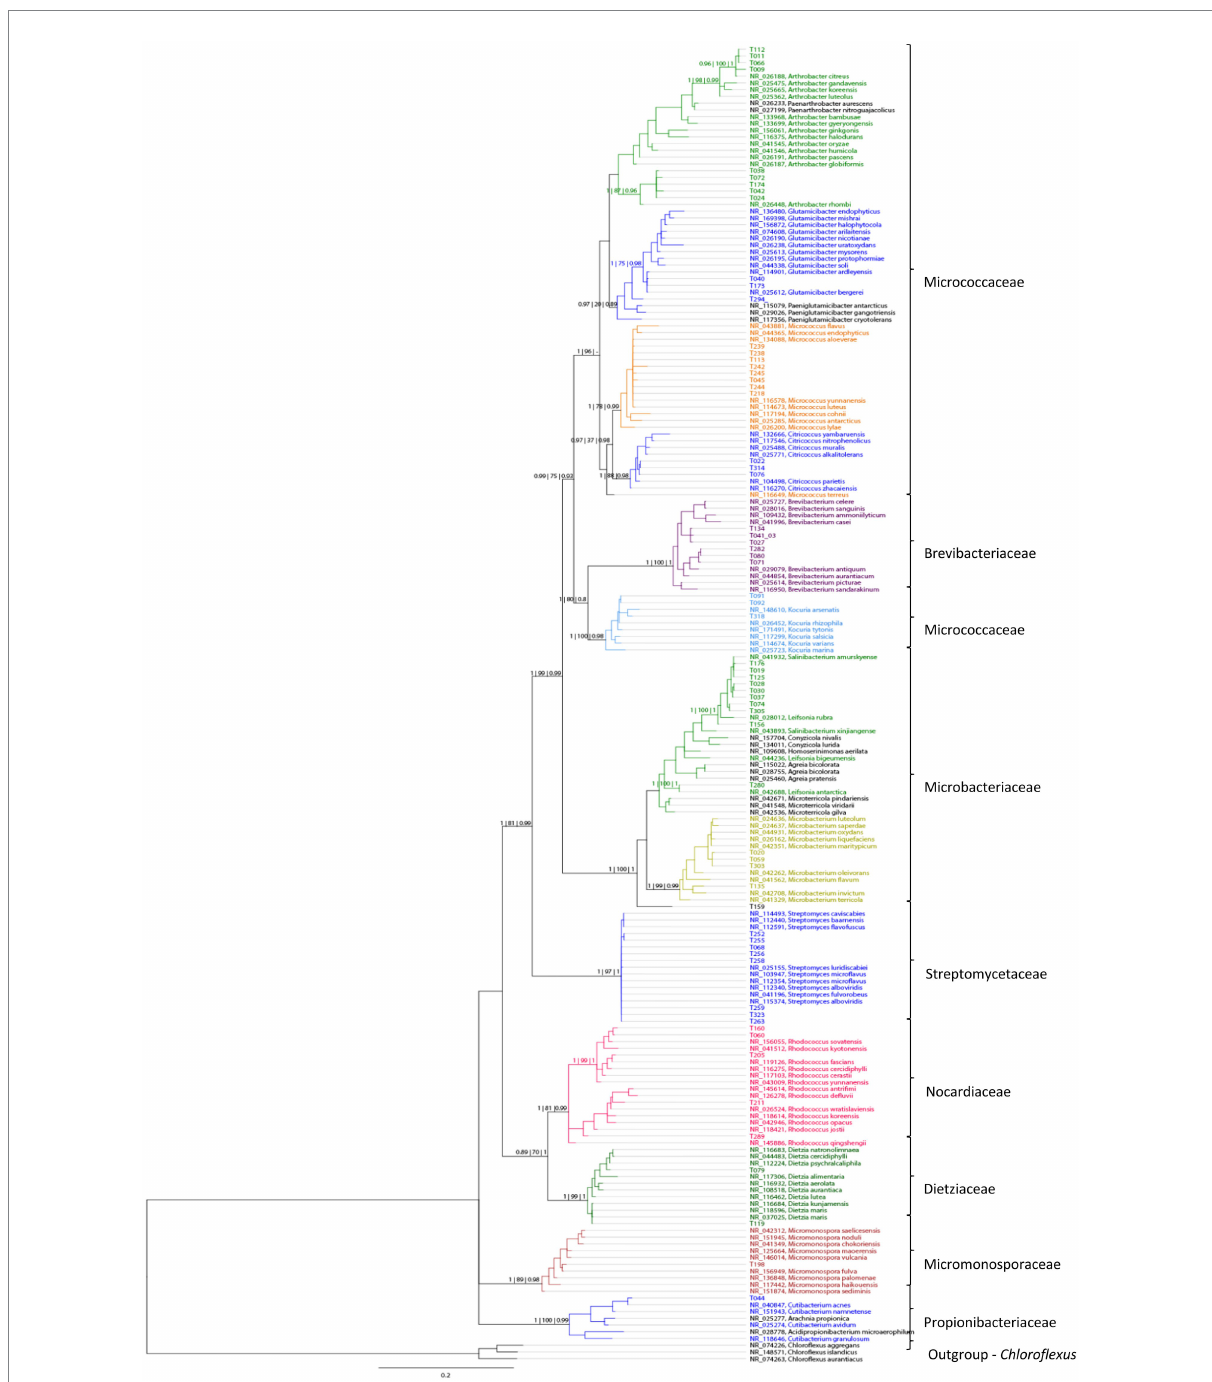
FIGURE 4 A phylogenetic tree based on comparison of 62 actinobacterial 16S rRNA sequences from 10 sampling sites, based on Bayesian analysis. New isolates are represented by numbers, while colors indicate their similarity to known taxa. Support values are given in the following order as Bayesian | Maximum likelihood | FastTree